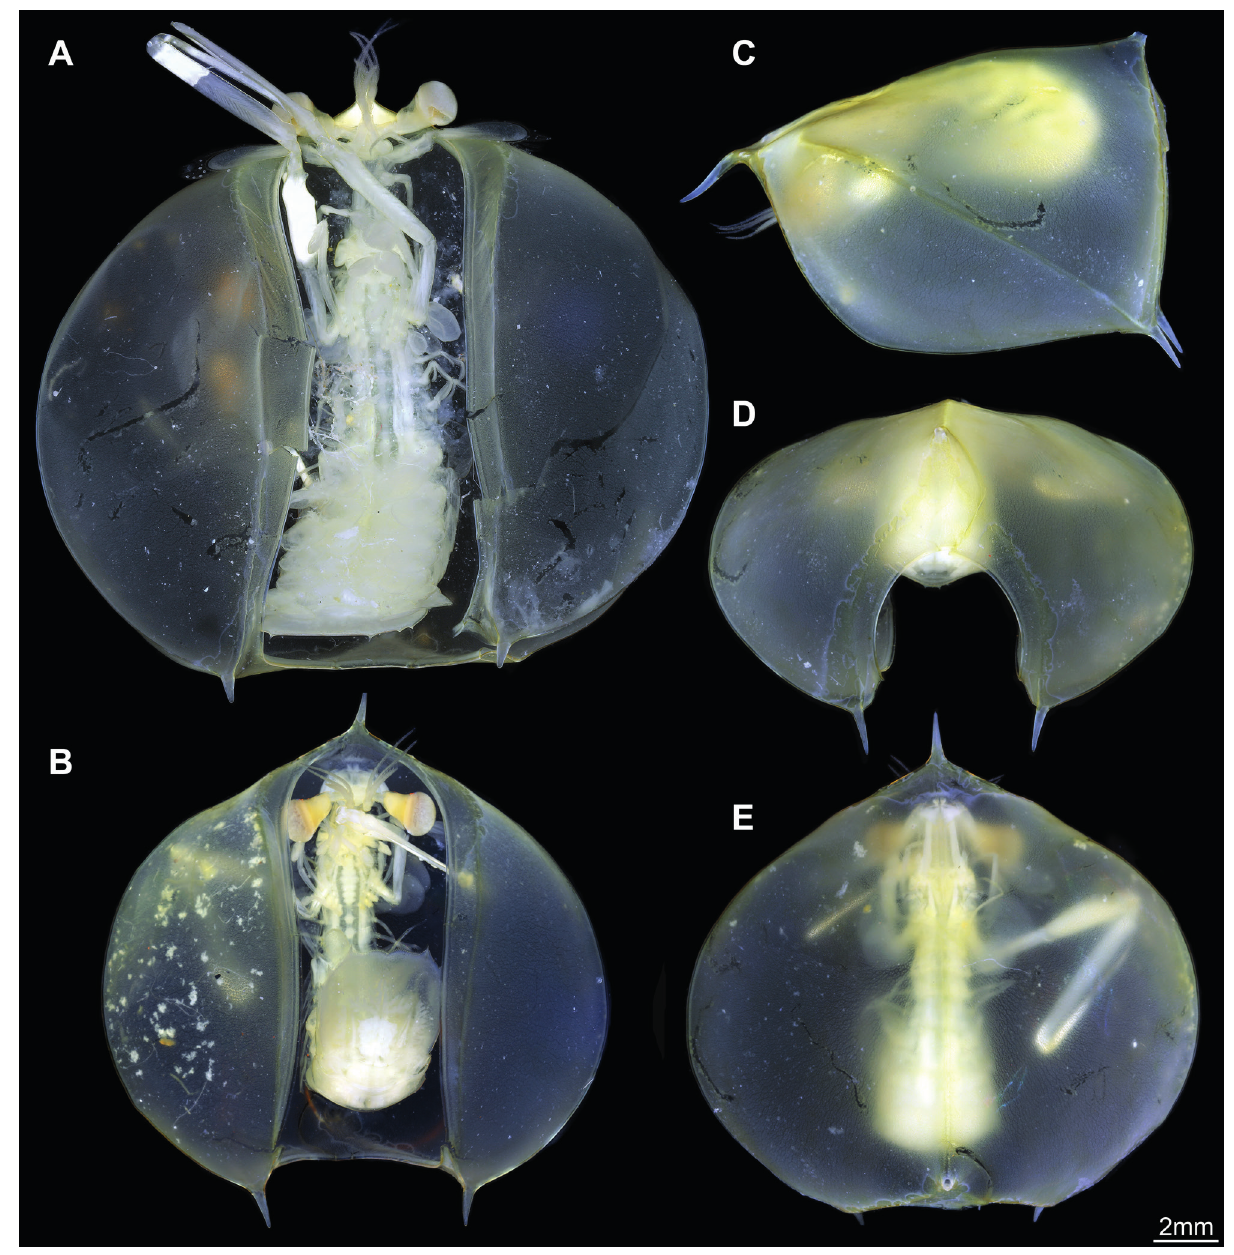
Figure 2. New morphotype 1, “balloon-larva”. A. ZMUC-CRU-8663, larger specimen; note the damaged shield. B–E. ZMUC- CRU-8662, smaller specimen. A, B. Ventral view. C. Lateral view; note the pronounced edge from the rostrum to the postero-lateral spine. D. Posterior view. E. Dorsal